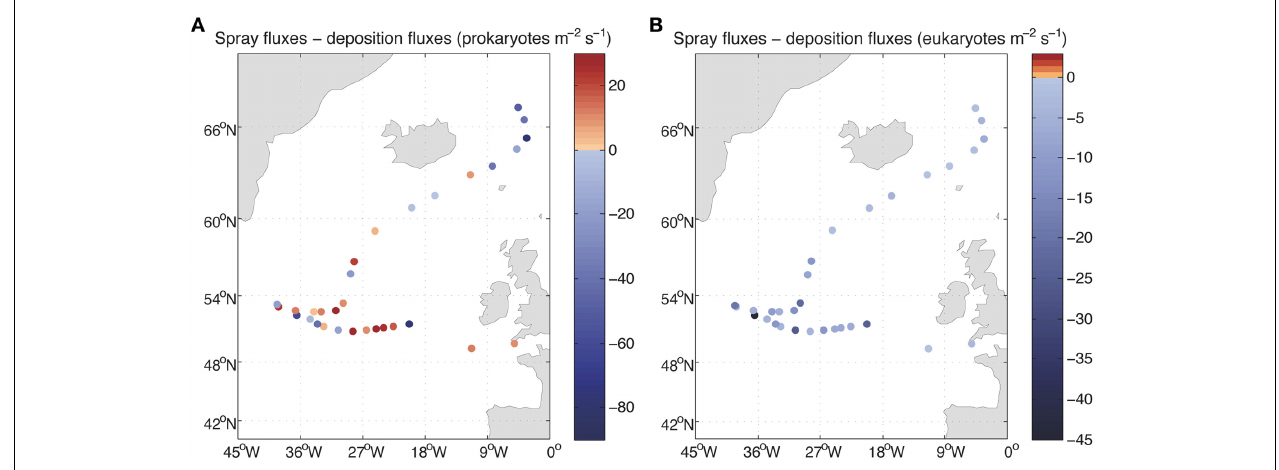
FIGURE 6 | Net fluxes of prokaryotes (A) and eukaryotes (B) between air and sea. The values lower than zero correspond to net fluxes from the atmosphere into the